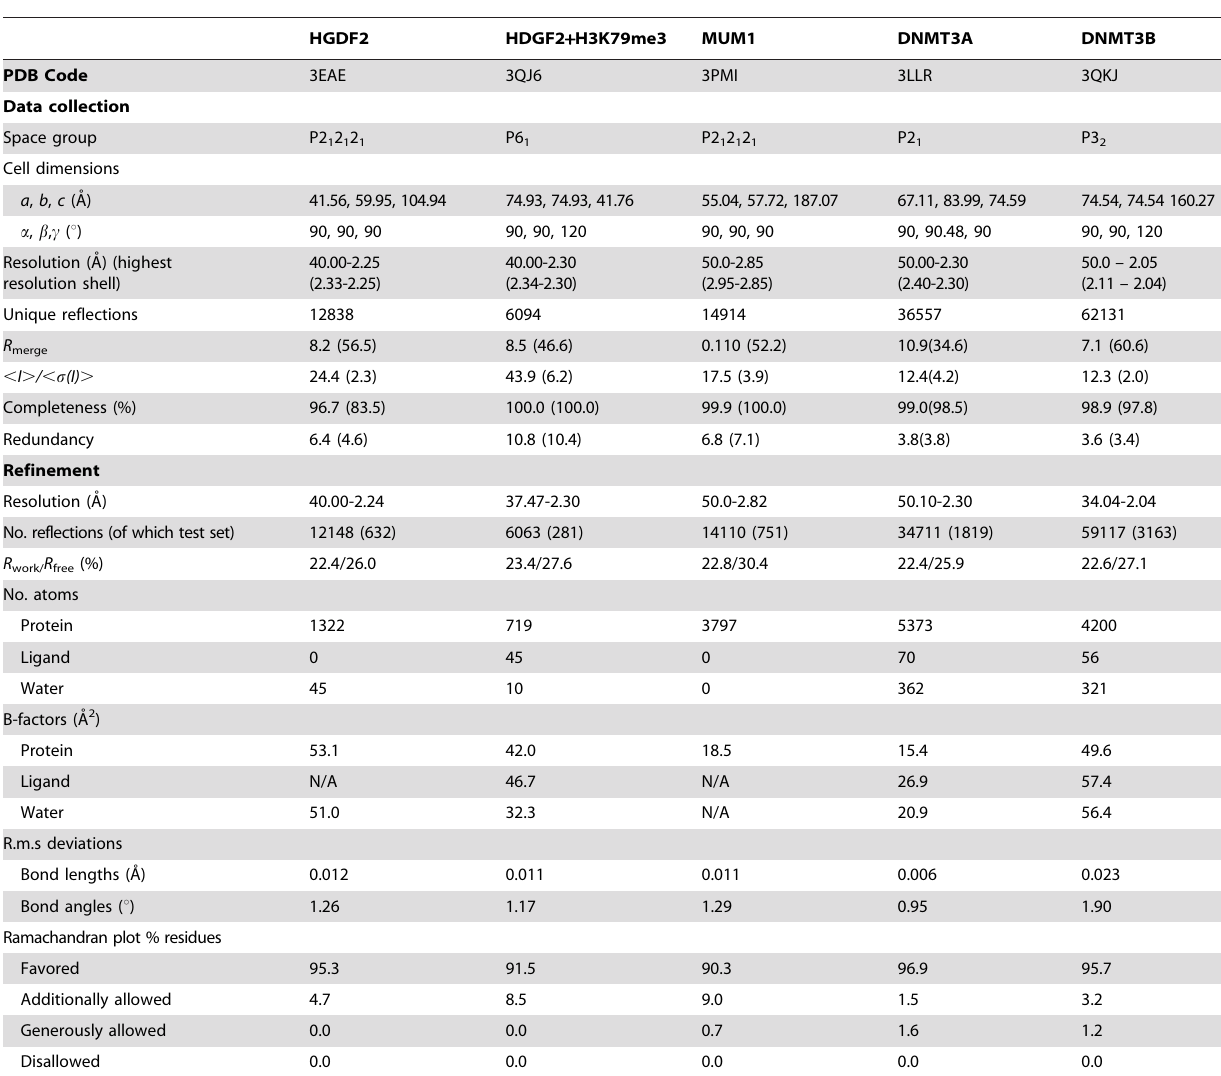
Table 3. Crystallography data and refinement